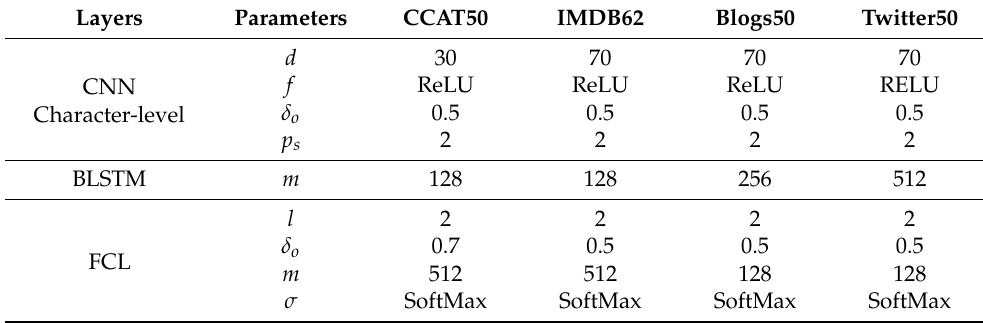
Table 3. The setting of hyperparameters in RDNN method on different